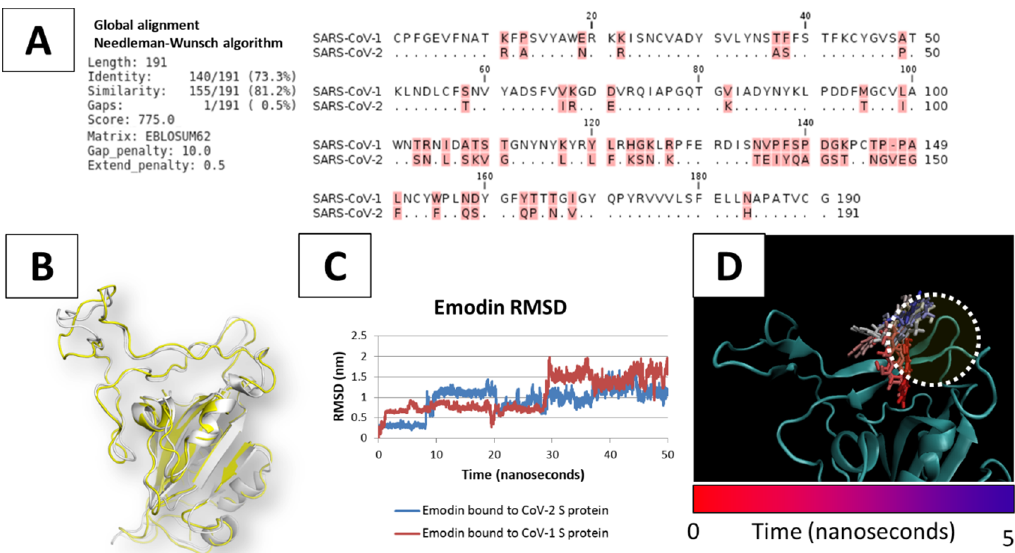
Figure 6. Comparison between SARS-CoV-1 and SARS-CoV-2. ( A ) Sequence alignment of S protein receptor binding domain (RBD) portions analyzed in this study. ( B ) Structure overlap of SARS-CoV-2 S protein RBD (white) and the homolog region of SARS-CoV-1 (yellow) (PDB codes 6ACG and 6M0J, respectively). ( C ) RMSD plot of emodin. ( D ) Time-step representation of emodin trajectory. The from-red-to-blue color switch indicates the stepwise changes of ligand coordinates along the MD simulation. The white dotted ring indicates the localization of the hotspot of interaction enriched in protein-protein contacts.